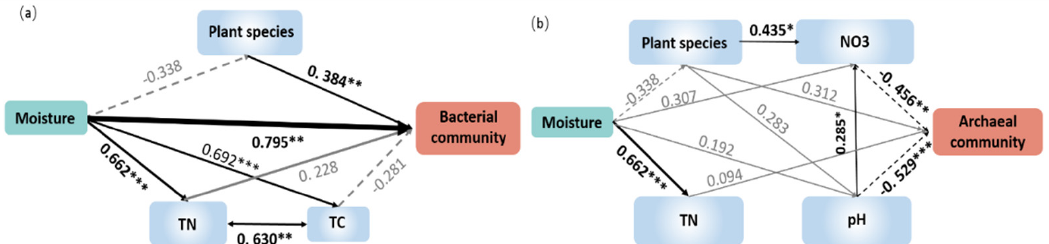
tors, and the absolute values of the Pearson correlation coefficient were labelled along the colored